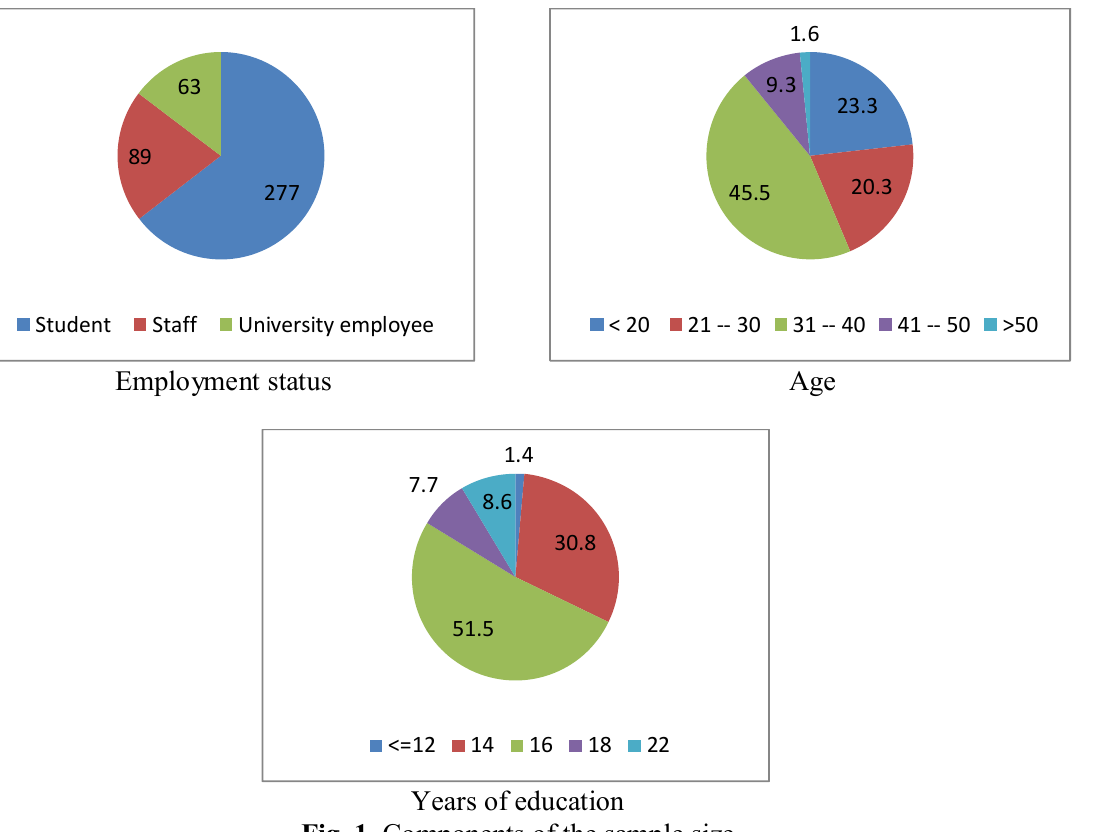
Fig. 1. Components of the sample